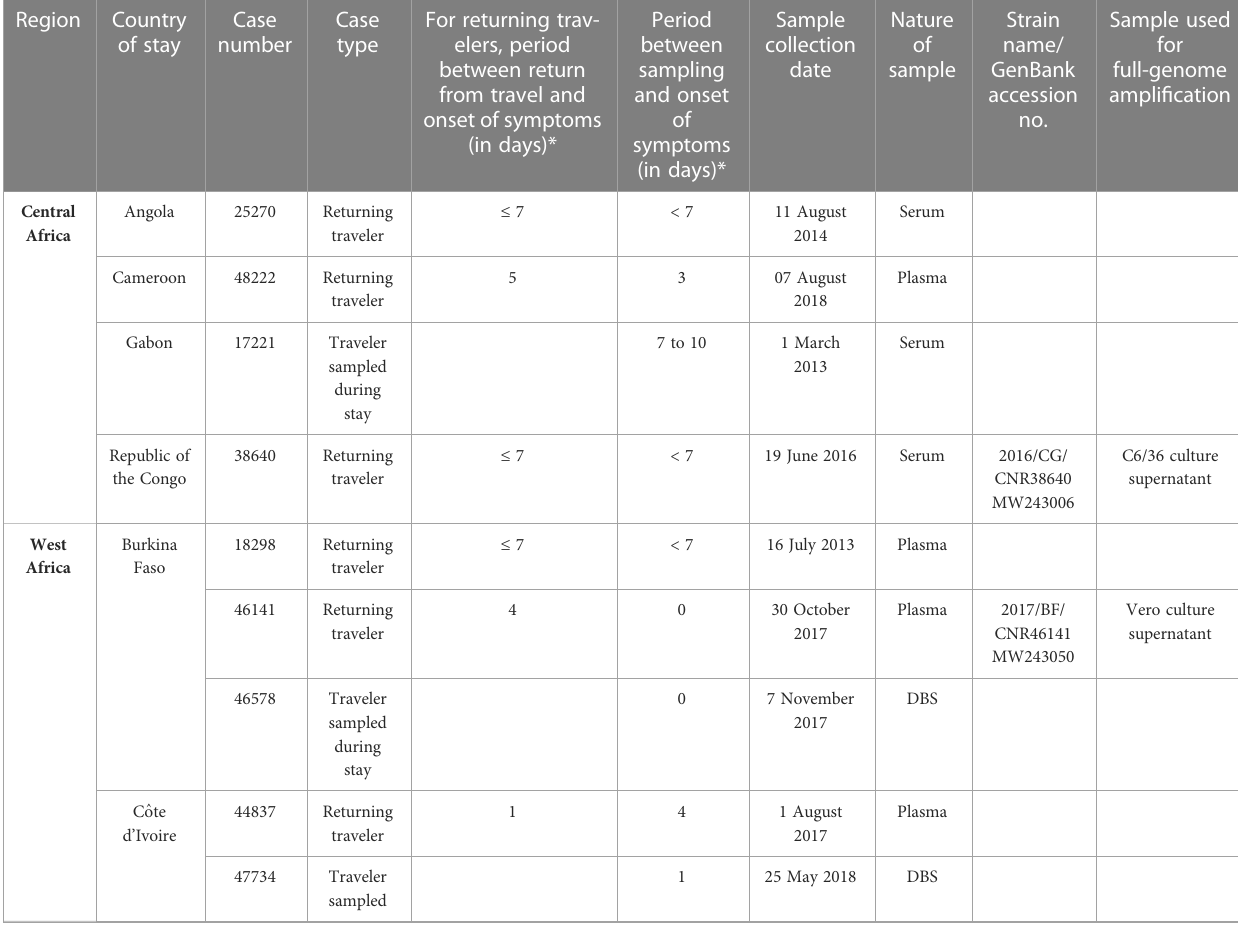
TABLE 1 Characteristics of DENV-1 cases analyzed in this study.